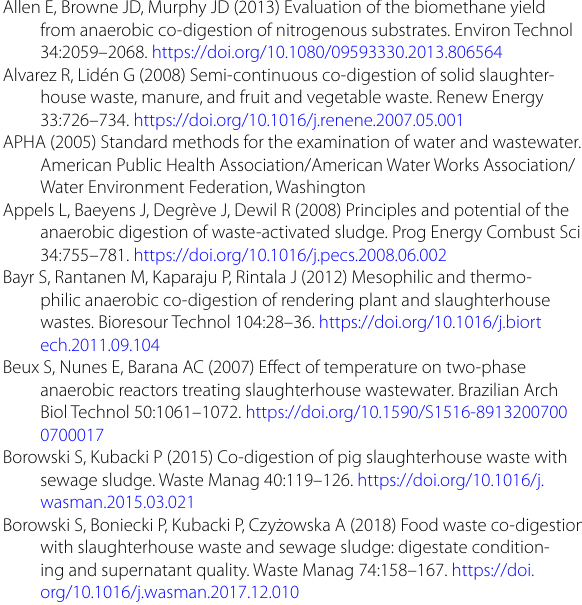
Additional file 1: Table S1. One-way ANOVA of the effects of different mixing ratios on %CH 4 (Significant at the 0.05 level). Table S2. Pearson correlation of some variables in methanogenic reactors with different mixing